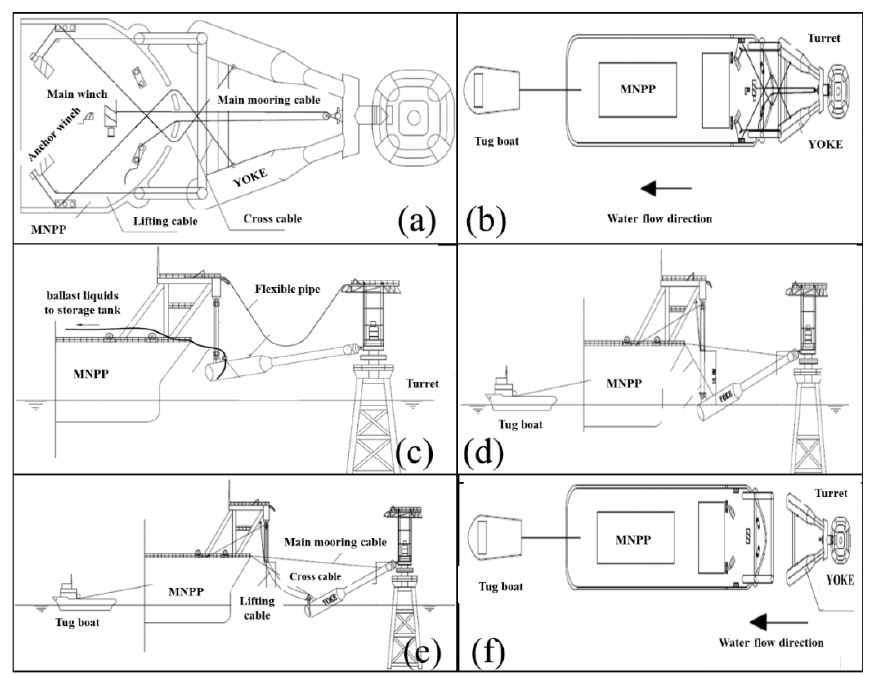
Figure 2. MNPP disconnect operation flow. ( a ) Pre-laying the crossover cables. ( b ) Stern tugging the position. ( c ) Yoke tank ballast liquid discharging. ( d ) Loosening of the lifting cable. ( e ) Backing up the nuclear power platform. ( f ) Removal of all working cables.